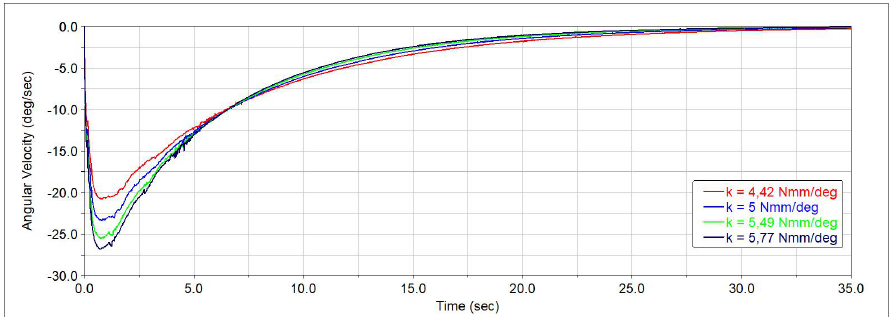
Figure 15. Spring-damper system time-rate angle of the first cell as a function of the simulation time and when the stiffness coefficient varies from 4.42 to 5.77 N · mm/deg.